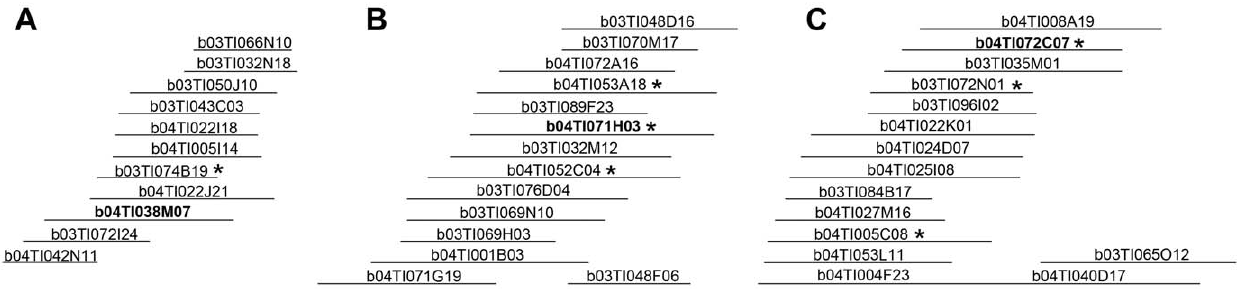
Figure 1. Three Nile tilapia BAC contigs contain vasa gene sequences. (A) Contig 311, (B) Contig 992 and (C) Contig 542. Asterisks indicate clones identified by a 4-step PCR screening for vasa gene sequences. Clones b04TI038M07 (38M07), b04TI071H03 (71H03), b04TI072C07 (72C07) were chosen for sequencing.